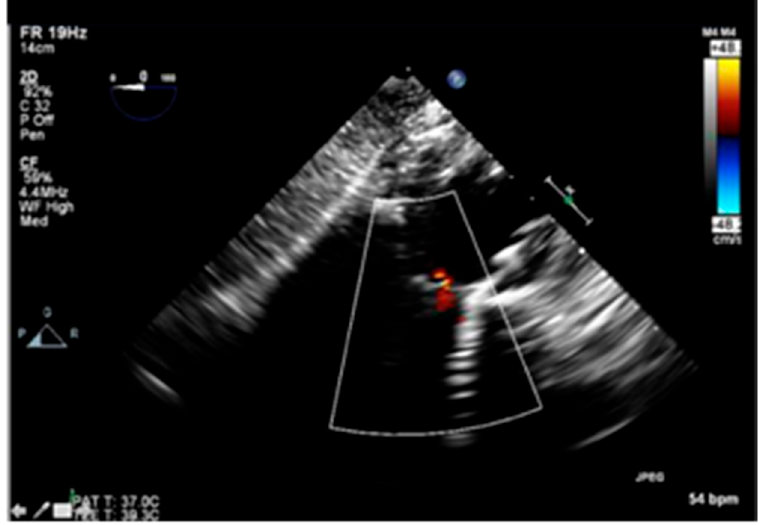
Figure 6. Trans-esophageal echocardiogram after valve deployment showing trace paravalvular leak. The TandemLife ® support was discontinued. The left common artery cannula was removed, and the Perclose sutures were tied. The right common femoral vein cannula and right common femoral artery sheath were removed, and the Perclose sutures were tied. The patient was transferred to the ICU in stable condition and was discharged two days after the procedure. At one month’s follow up, TTE showed a well-seated valve with no paravalvular leak and transvalvular mean gradient of 12 mmHg.